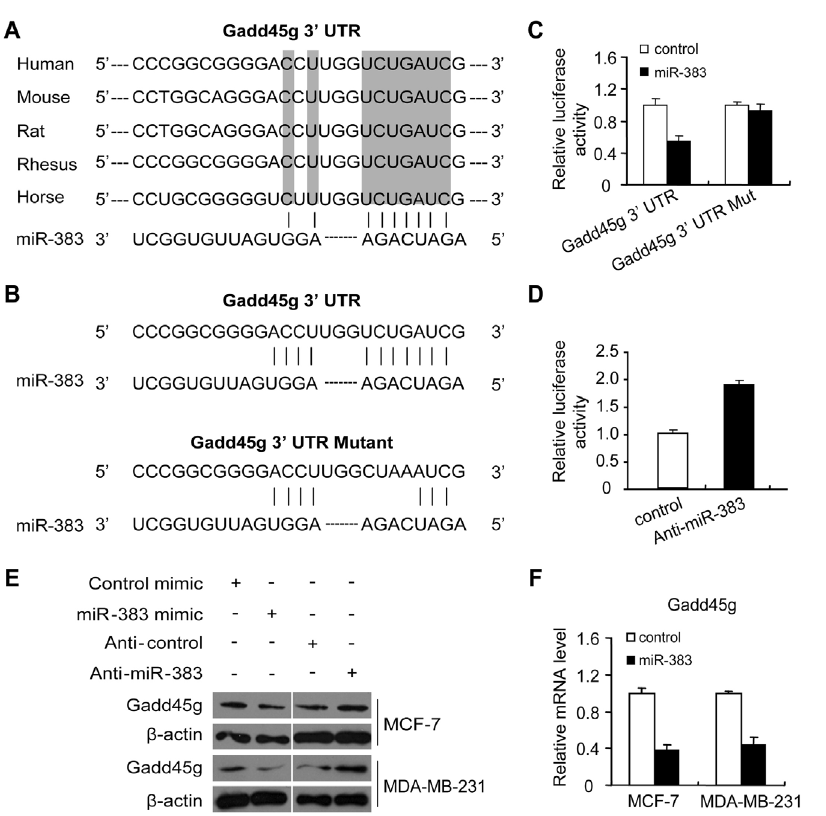
Figure 1. miR-383 represses Gadd45g expression by directly targeting Gadd45g 3 9 -UTR. (A) Schematic representation of miR-383 binding site on the Gadd45g 3 9 -UTR. Shaded texts indicate the conserved sequences among human, mouse, rat, rhesus monkey and horse. (B) Gadd45g 3 9 -UTR sequence containing the predicted target sites was inserted into the pMIR reporter vector, immediately downstream the luciferase gene. The mutant reporter construct was generated by introducing four-mismatch mutation. (C) Relative luciferase activities of Gadd45g 3 9 -UTR reporter or mutated Gadd45g 3 9 -UTR reporter in MCF-7 cells with or without miR-383 mimic. Firefly luciferase reading was normalized to that of the Renilla luciferase. Values are means ¡ SD. (D) MCF-7 cells were co-transfected with the Gadd45g 3 9 -UTR reporter construct, and anti- miR-383 or anti-control, supplemented by pRL vector, and luciferase activities were analyzed after 48 h. Values are means ¡ SD. (E) The effect of miR-383 mimic or anti-miR-383 on Gad4d45g protein levels. Protein expression of Gadd45g was determined by western blotting in MCF-7 and MDA-MB-231 cells at 48 h after transfection. b -actin was used as a loading control. (F) Relative Gadd45g mRNA expression was measured by qRT-PCR in MCF-7 and MDA-MB-231 cells transfected with miR-383 mimic or control. Levels were normalized to GAPDH expression. Values are means ¡